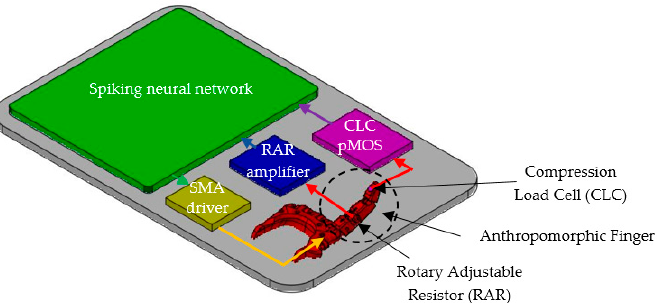
Figure 5. Experimental setup showing the structure of the bioinspired system which includes the spiking neural network, the artificial finger, and auxiliary electronics (SMA driver, RAR amplifier and the CLC pMOS).